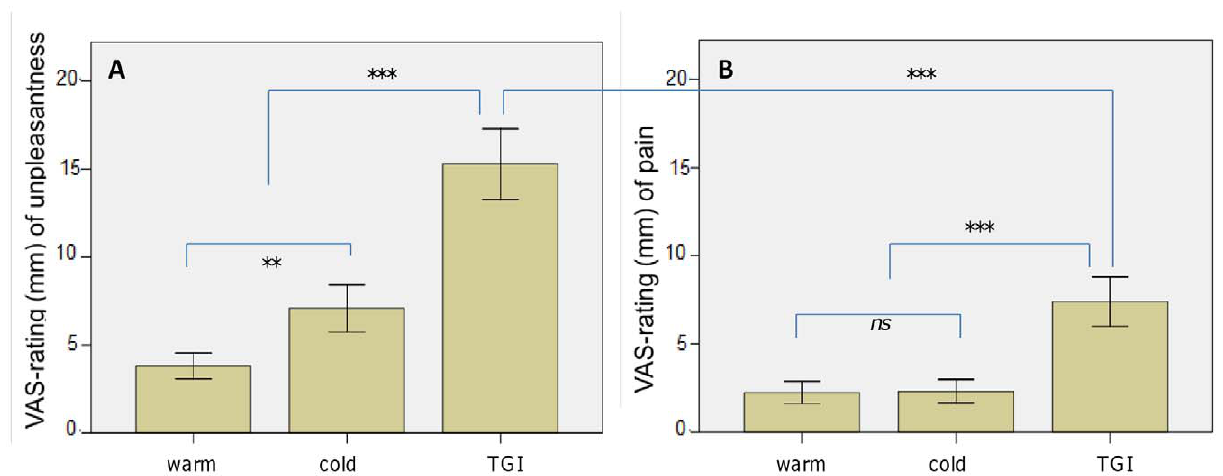
Figure 3. Validation of the thermal grill illusion for affective and sensory dimensions, all subjects. The thermal grill illusion was tested along with its constituent temperatures, in a randomized and counterbalanced order. Subjects provided VAS-ratings of both the affective- motivational (i.e. unpleasantness, see panel A) and sensory-discriminatory (i.e. pain, see panel B) dimensions for each condition. Validation of the thermal grill illusion, for all subjects: *** = significant at p , 0.001, ** = significant at p , 0.01, ns = not significant.